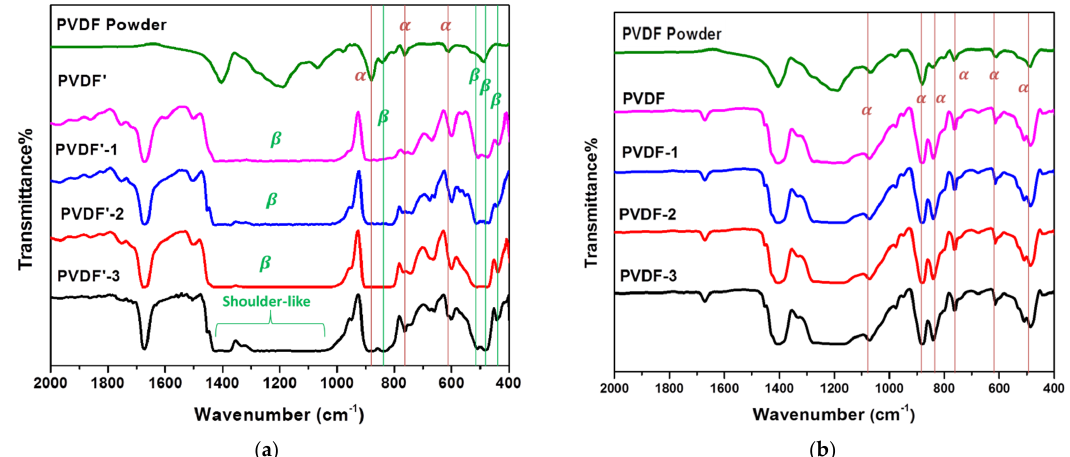
Table 1. Summary table of the reported wavenumber values of alpha beta and gamma phases in literature.